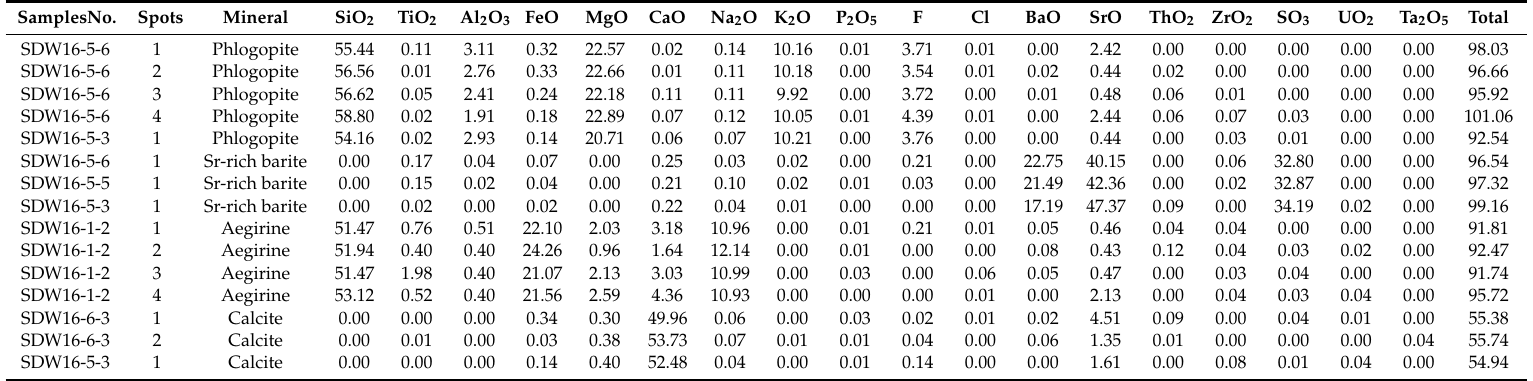
Table 5. Compositions of representative gangue minerals formed during the hydrothermal stage in the Weishan deposit. SamplesNo.